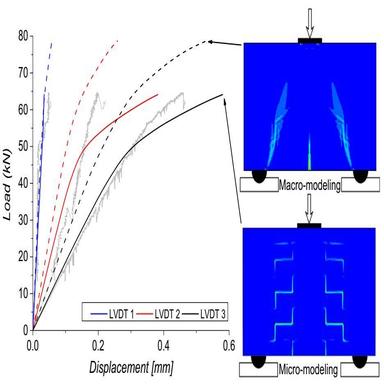
Numerical result of panel subjected to flexural loading.